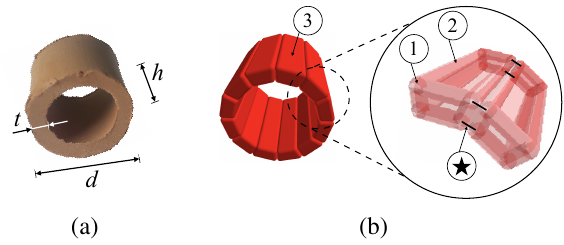
Figure 1. (a) Crushable shell made of backed clay. The tubular geometry is described by diameter d , thickness t and height h h such that d 20 mm and t 2 . 5 mm. (b) A cluster is a ⇡ ⇡ ⇡ numerical representation of shell generated with 12 rigid sectors bonded by four corner-to-corner links ? . Each sector is build  from the 1 – corner spheres, 2 – tubular edges and 3 – side